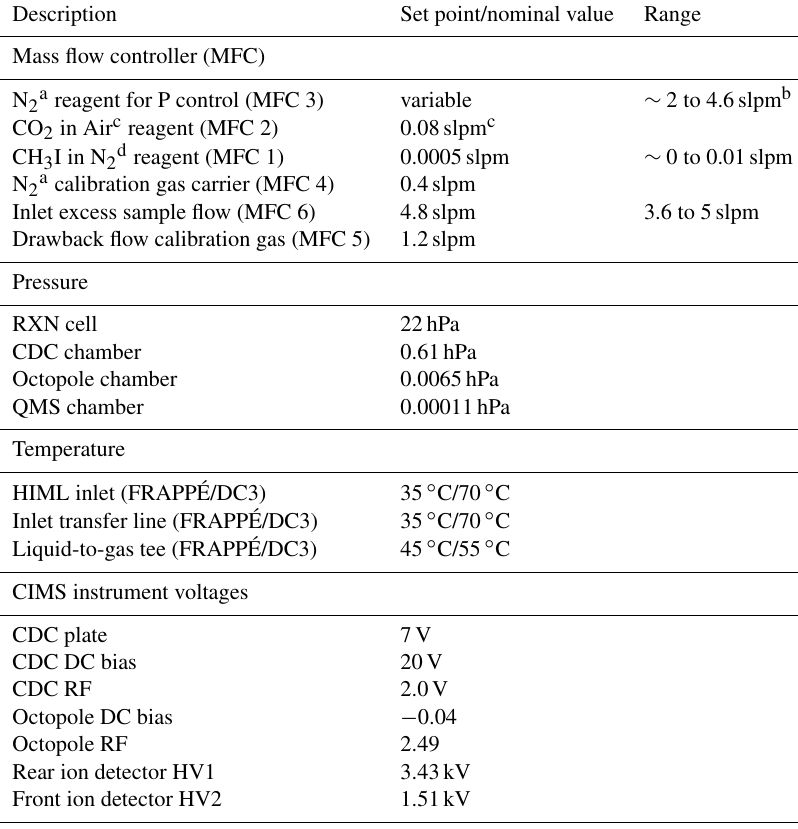
Table 1. PCIMS instrument settings: voltages, pressures, temperatures, and MFC set